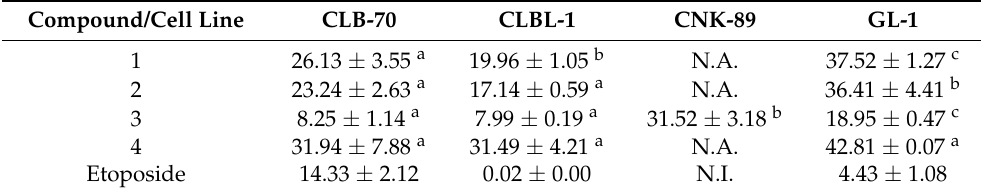
Table 1. IC 50 ( µ g/mL concentration of the tested compound that inhibits proliferation of 50% of cells) for all tested compounds and all cell lines used in the study, obtained by PI staining after 48 h treatment. The results are presented as mean ± standard deviation (SD) of three separate experiments with three wells each. Statistical differences were analyzed using one-way ANOVA followed by Tukey’s multiple comparison test. Values without common letters (a, b, c) in the superscript differ statistically ( p < 0.05). The table shows differences in the strength of action of each compound on selected cell lines. N.A.—not achieved. N.I.—not investigated. Compound/Cell Line CLB-70